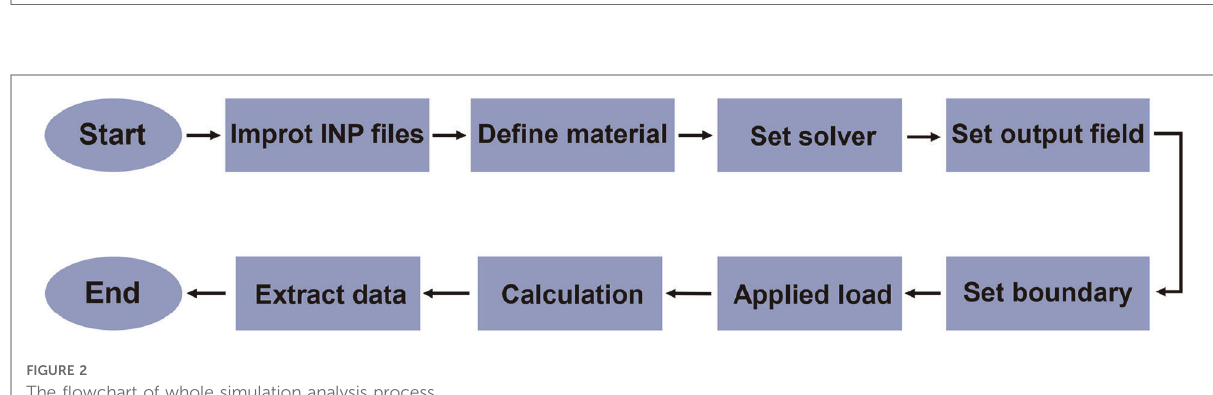
FIGURE 1 The design process of a 3D printed porous prosthesis. ( A ) CT scan of both the affected and unaffected sides. ( B ) 3D reconstruction was performed based on CT images, then according to the principle of mirror symmetry, the shape of the unaffected bone was converted to the model of the affected side. ( C ) The bone defect was fi lled by the simulative 3D-printed prosthesis. ( D ) The internal fi xation was simulated via a medical- industrial interactive platform. ( E ) Finally, the personalized 3D printed porous prosthesis could be fabricated successfully.